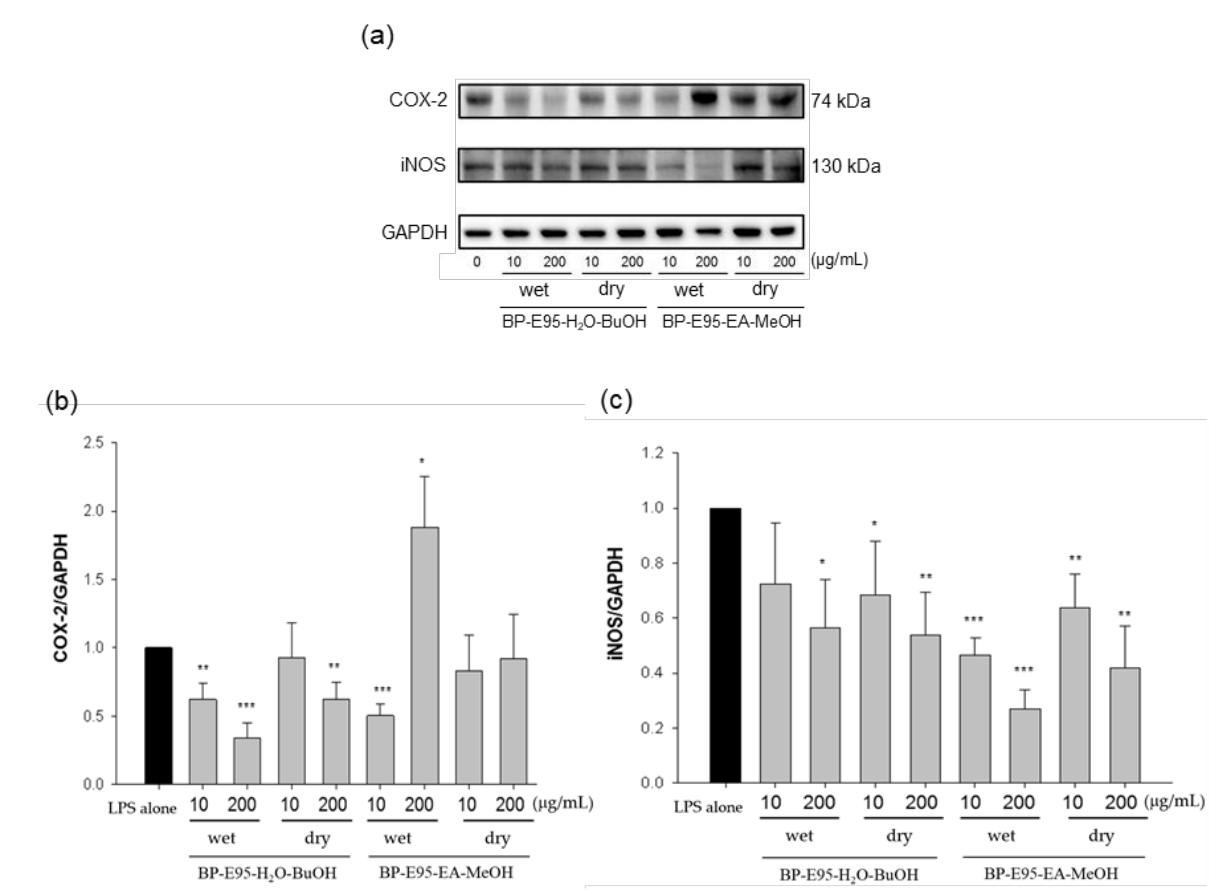
Figure 3. Effects of butanol and methanol subfractions of BP on iNOS or COX-2 protein expressions in LPS-stimulated RAW264.7 cells. Cells were pretreated with the indicated BP extracts for 1 h and then stimulated with LPS (100 ng/mL) for 12 h. Whole-cell lysates were subjected to Western blotting analysis using the anti-COX-2 and anti-iNOS antibodies or an anti-GAPDH antibody as a loading control ( a ). The extents of protein expression are expressed as multiples of LPS alone ( b , c ) and quantified by densitometric analysis using Quantity One software (Bio-Rad). Bar values are means ± SD of three independent experiments in these assays. A significant difference from the LPS control is indicated as * p < 0.05, ** p < 0.01, or *** p < 0.001 according to Student’s t